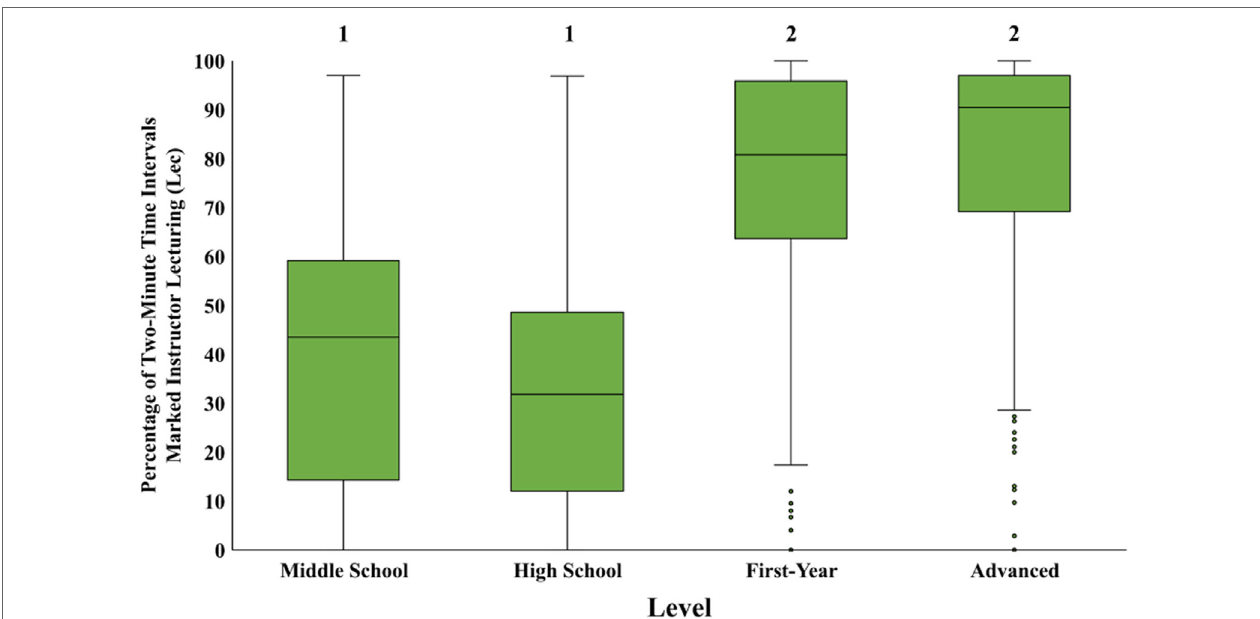
FigUre 4 | Comparison of the relative frequency of the Classroom Observation Protocol for Undergraduate STEM code Instructor Lecturing (Lec) for middle school, high school, first-year university, and advanced university classes. Box-and-whisker plots showing the median and variation between the four instructional levels. The line in the middle of the box represents the median percentage of 2-min time intervals for the class sessions in each level. Boxes represent the interquartile range, whiskers represent 1.5 times the interquartile range, and data points not included in 1.5 times the interquartile range are shown with dots. Levels labeled with different numbers indicate a significant difference between mean ranks by a post hoc Dunn’s pairwise comparison (Kruskal–Wallis Test, χ 2 = 153.03, df = 3, N = 482, p < 0.001; Dunn’s pairwise comparisons, p < 0.001 for levels labeled with different